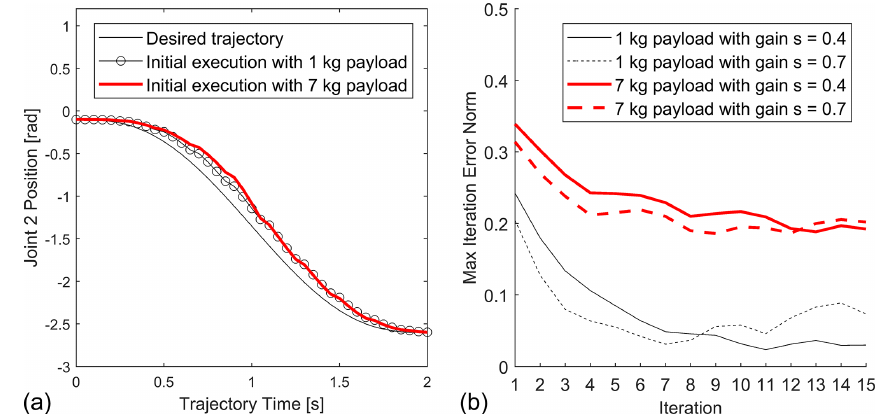
Figure 11. (a) Desired trajectory and its execution with different payloads. (b) Comparison of the convergence of the ILC process with different payloads and different values of the multiplier gain s